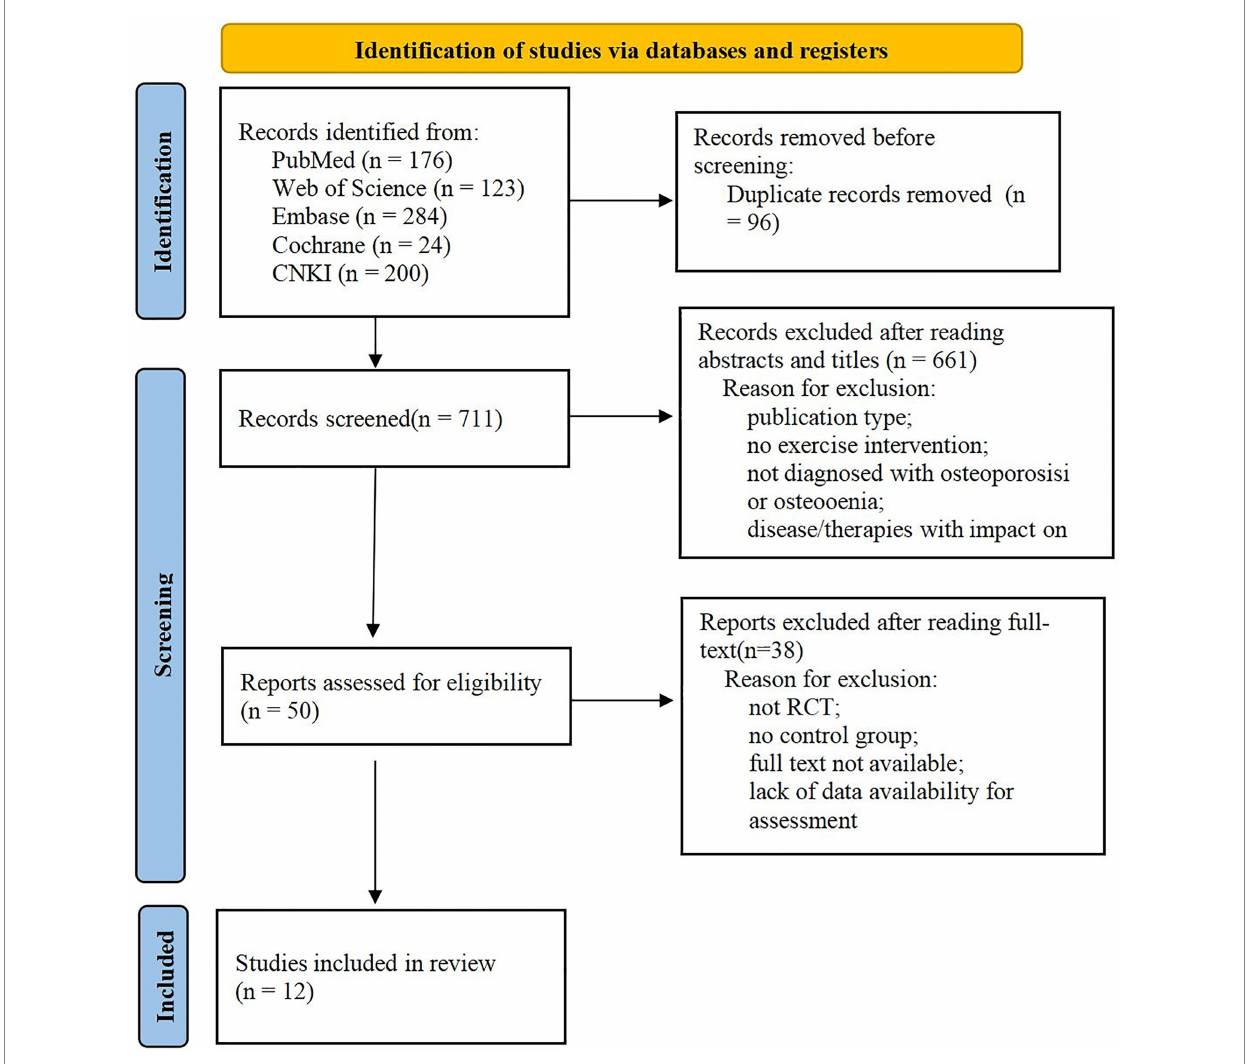
FIGURE 1 PRISMA flow